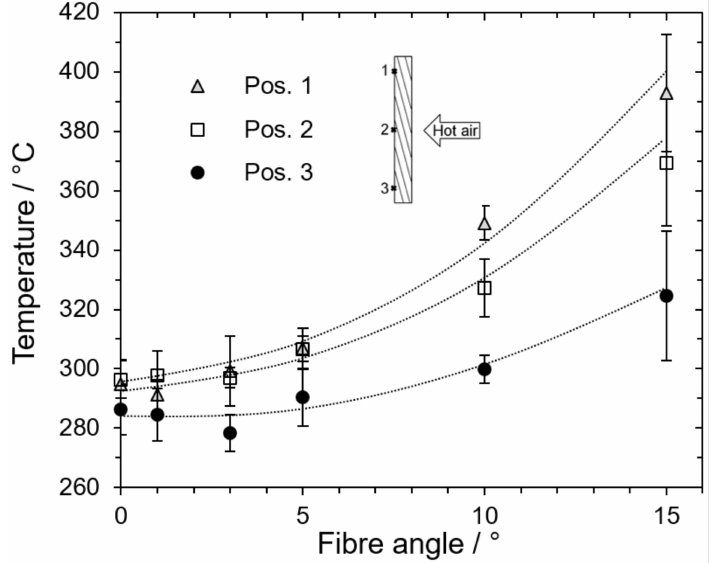
Figure 9. Reached equilibrium back side temperatures after ca. 30 s (see Figure 8).